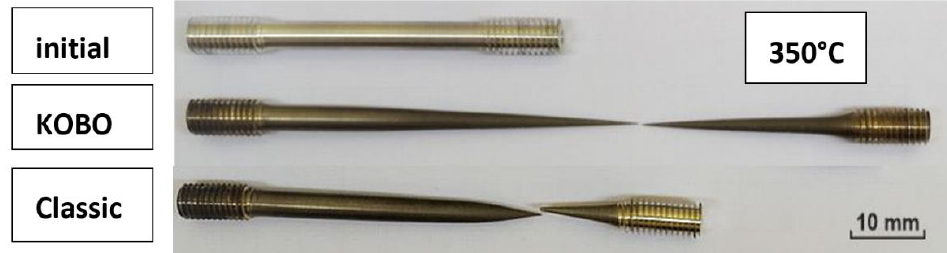
Figure 2. The appearance of samples for the tensile test and after the test.